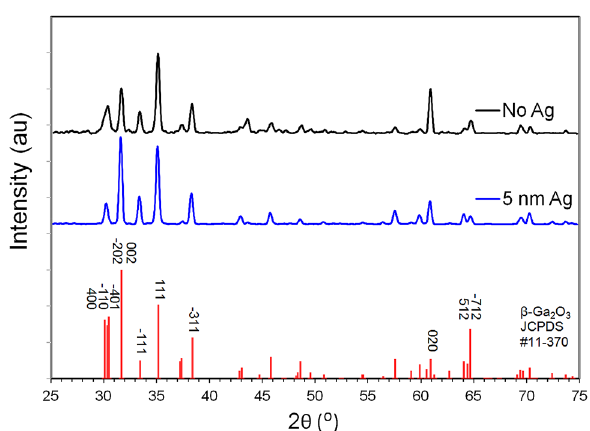
Figure 3. θ–2θ x-ray diffraction (XRD) pattern, indexed in comparison to JCPDS 11-370, for β-Ga 2 O 3 grown at 1000